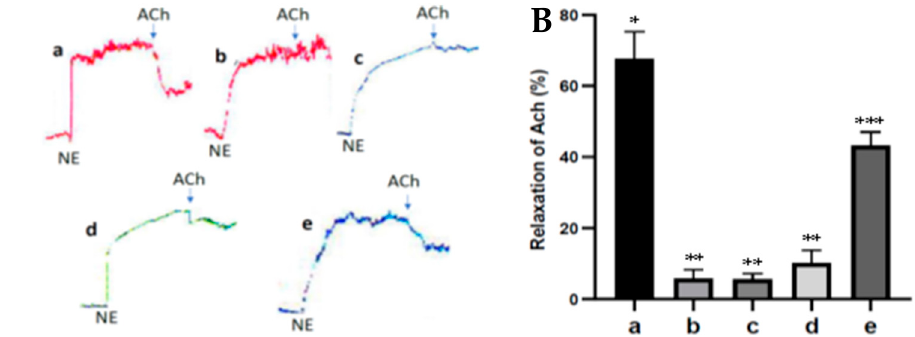
Figure 5. A. The response of 1 µM Ach relaxation to 1 µM NE contractions from various treatments Figure 5. ( A ). The response of 1 µ M Ach relaxation to 1 µ M NE contractions from various treatments in rats’ aortas: control rats ( a ); diabetic rats ( b ); fucoidan nanoparticles at doses of 75 ( c ), 150 ( d ), and in rats’ aortas: control rats a; diabetic rats b; fucoidan nanoparticles at doses of 75 c, 150 d, and 300 mg/kg BW ( e ). B. The relaxation of Ach to NE contractions expressed in %. * - ***The columns 300 mg/kg BW e. ( B ). The relaxation of Ach to NE contractions expressed in %. *, **, *** The columns with different letters show significance between groups ( p < 0.05). with different letters show significance between groups ( p < 0.05).